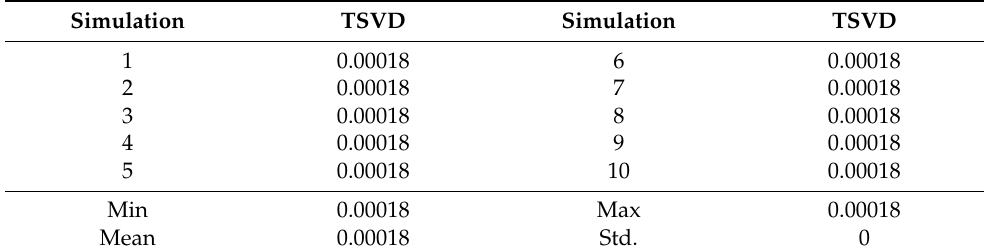
Table 1. Stochastic behaviour of SALFJA on IEEE-15 bus test system.